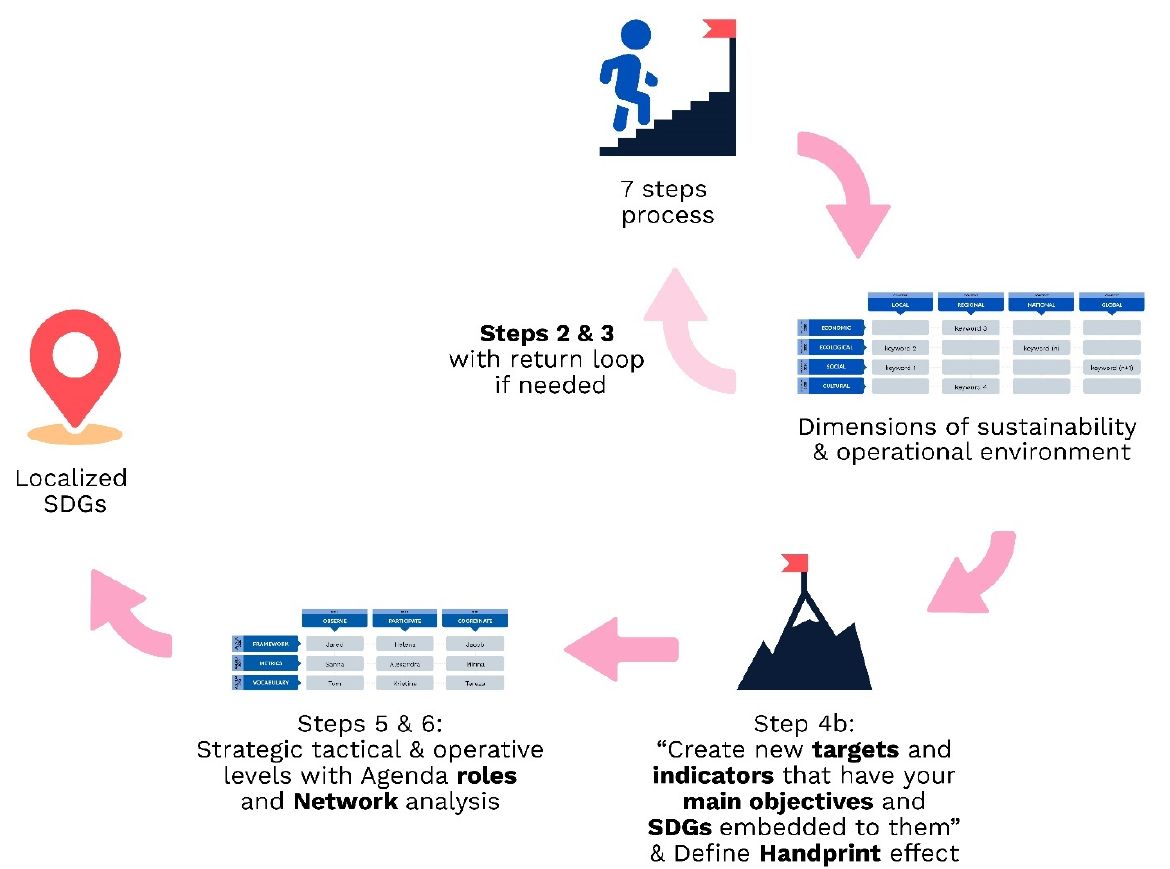
Figure 5. The main steps of the SST process.